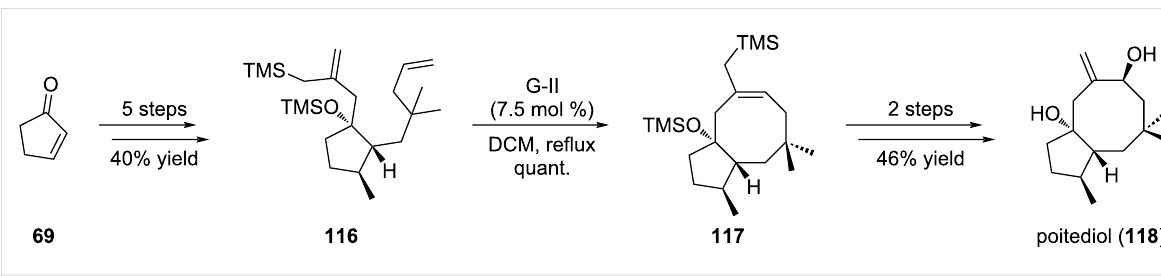
Scheme 21: Synthesis of poitediol ( 118 ) using the allylsilane ring-closing